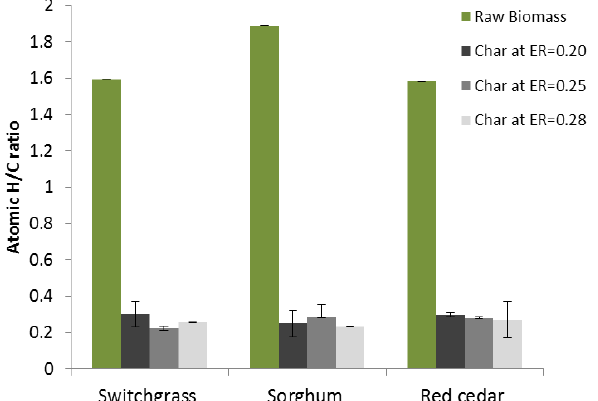
Figure 3. Atomic H/C of raw biomass and char obtained at equivalent ratios of 0.2, 0.25 and